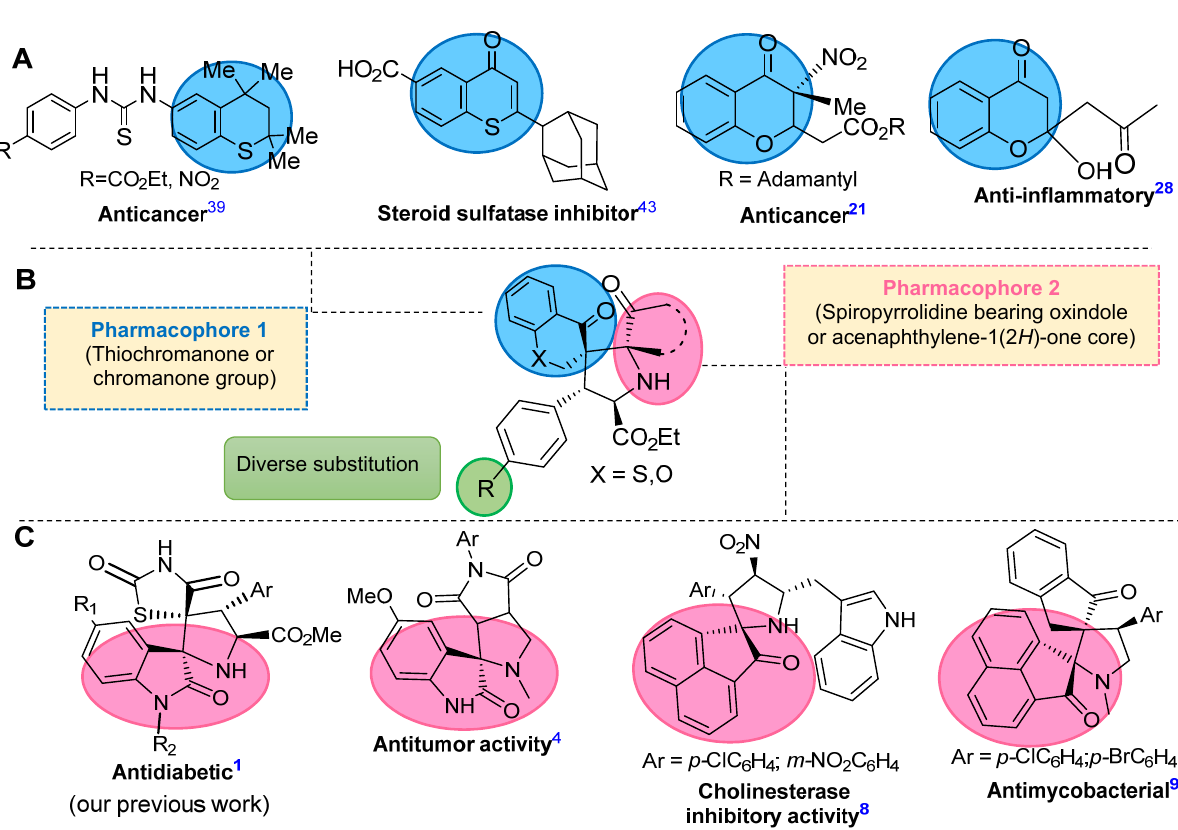
Figure 1. ( A ) Biologically relevant thiochroman, thiochromanone, and chromanone derivatives, ( C ) Biologically relevant spiropyrrolidines bearing oxindole or acenaphthylene-1(2 H ) - one moieties, and ( B ) Our target compounds.